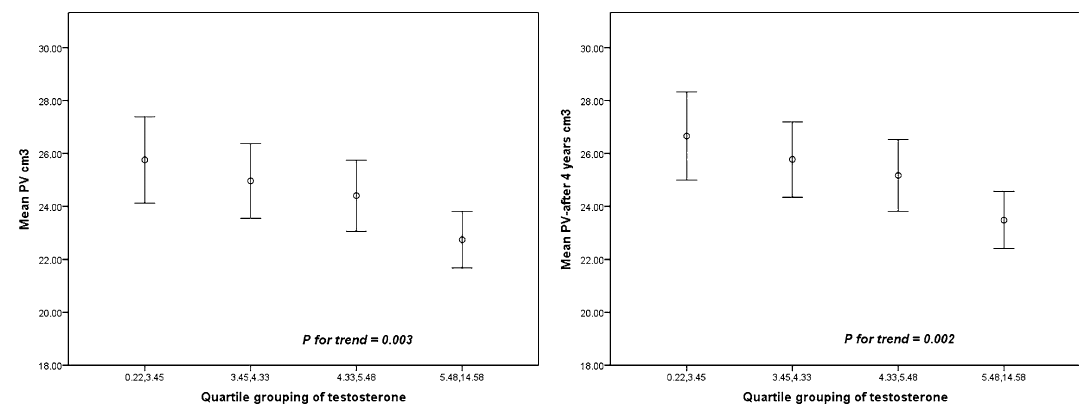
Figure 2. Mean prostate volume and prostate volume after 4 years adjusted for age. White circle indicates mean. Lower and upper bar indicates 95%